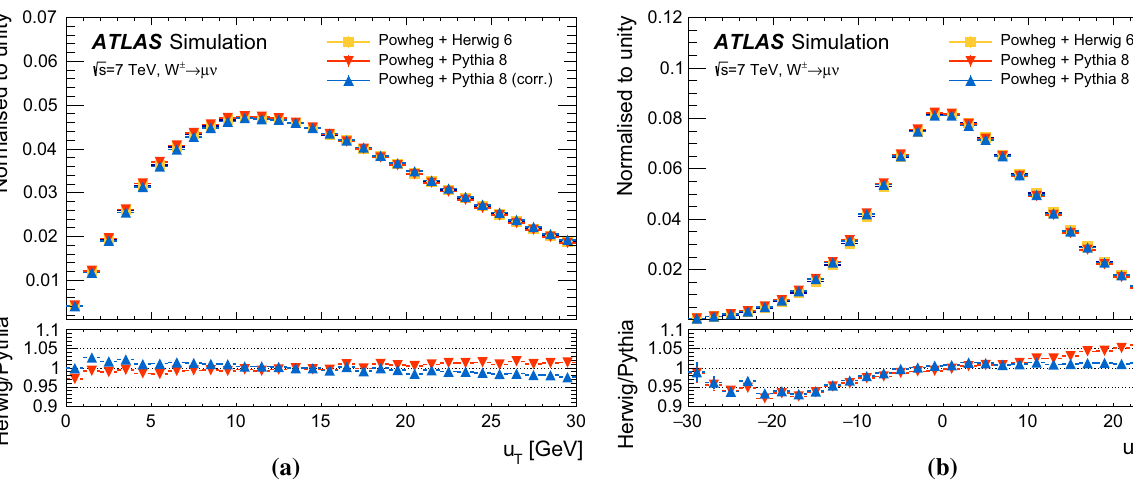
Fig. 21 Distributions of a u T and b u (cid:7) (cid:5) in W → μν events sim- ulated using Powheg+Pythia 8 and Powheg+Herwig 6 after all analysis selection cuts are applied. The Powheg+Pythia 8 distribu- tions are shown before and after correction of the recoil response